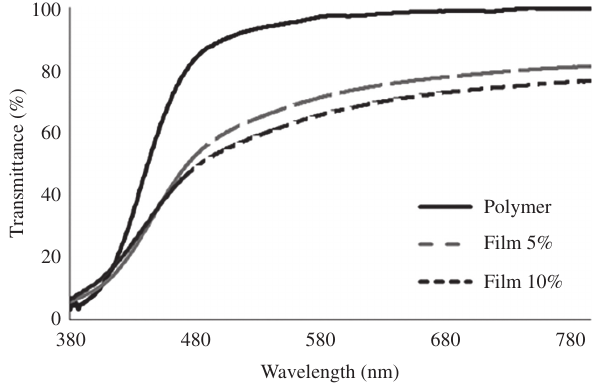
Figure 5 UV-vis spectra of PAI 4 and PAI-nanocomposite films 4a and